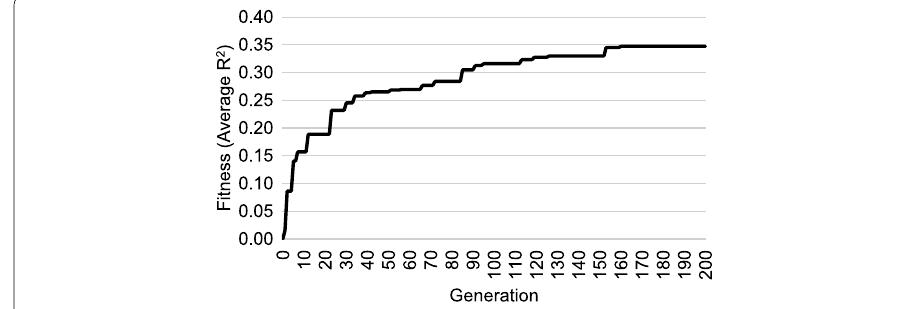
Fig. 3 Changes in tree fitness for each generation at the outer level